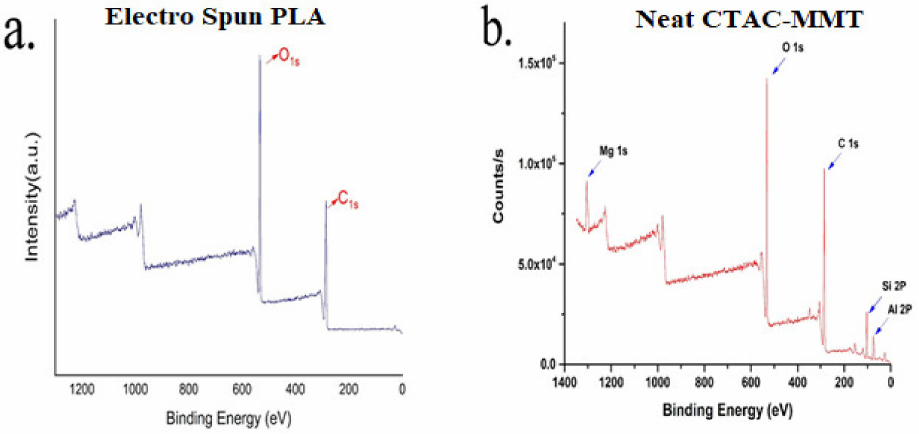
Figure 8. The graphic representation of XPS; ( a ) XPS spectrum of high-resolution C / O on PLA and,